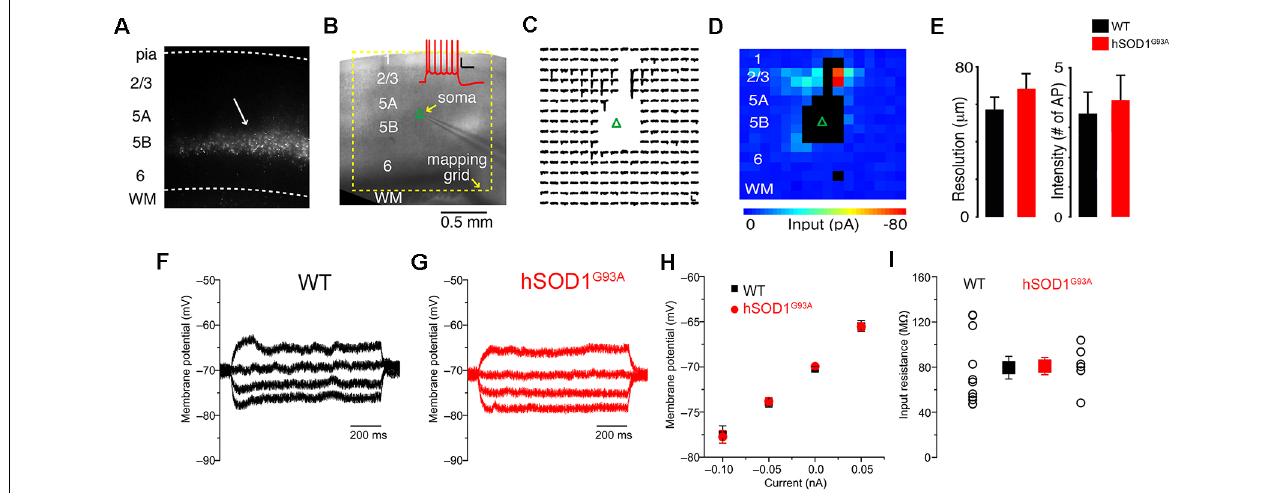
FIGURE 1 | Excitation profiles (EPs) and intrinsic properties of corticospinal motor neurons (CSMN) in the motor cortex of wild type (WT) and hSOD1 G93A mice at P30. (A) Retrograde bead labeling of CSMN in the motor cortex. (B) Bright-field image of mapping configuration for CSMN (inset); Corticospinal action potentials generated from 100 pA current injection. (C) Trace map (16 × 16,100 µ m spacing) showing EPSCs following stimulation of local presynaptic areas. The blank area represents areas that resulted in the direct stimulation of the recorded neuron. (D) Color map representing local excitatory inputs in (C) . (E) Left : resolution of photostimulation (the mean distance of spike evoking sites from the soma), right : intensity of photostimulation (total number of spikes per map per cell); WT (black) and hSOD1 G93A (red). The intrinsic properties of neurons from hSOD G93A and WT mice were largely identical. The input resistance was measured from the slope of a linear fit to the voltage response to hyper- and depolarizing steps: Representative recordings of a (F) WT and (G) hSOD1 G93A CSMN. (H) Average V-I plot of WT (black) and hSOD1 G93A (red). (I) Summary plot showing that the input resistance is very similar between the groups (WT: n = 10; hSOD1 G93A : n =